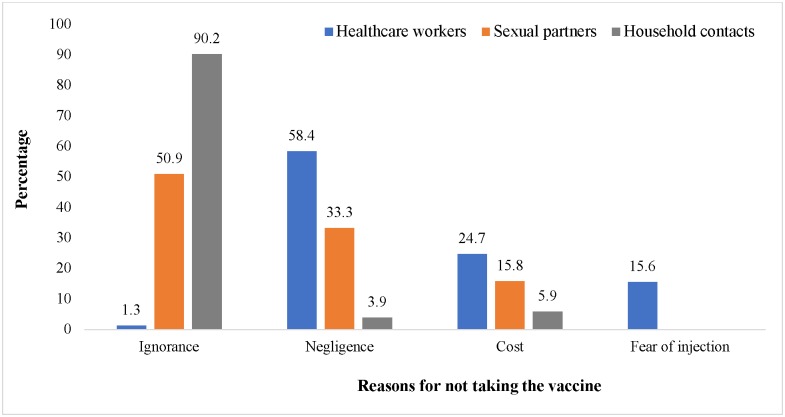
Non-vaccinated individuals and reasons for not taking the vaccine.NB: Ignorance: Not being aware of the fact that there is an HBV vaccine. Negligence: Aware of the HBV vaccine and its importance yet not vaccinated.